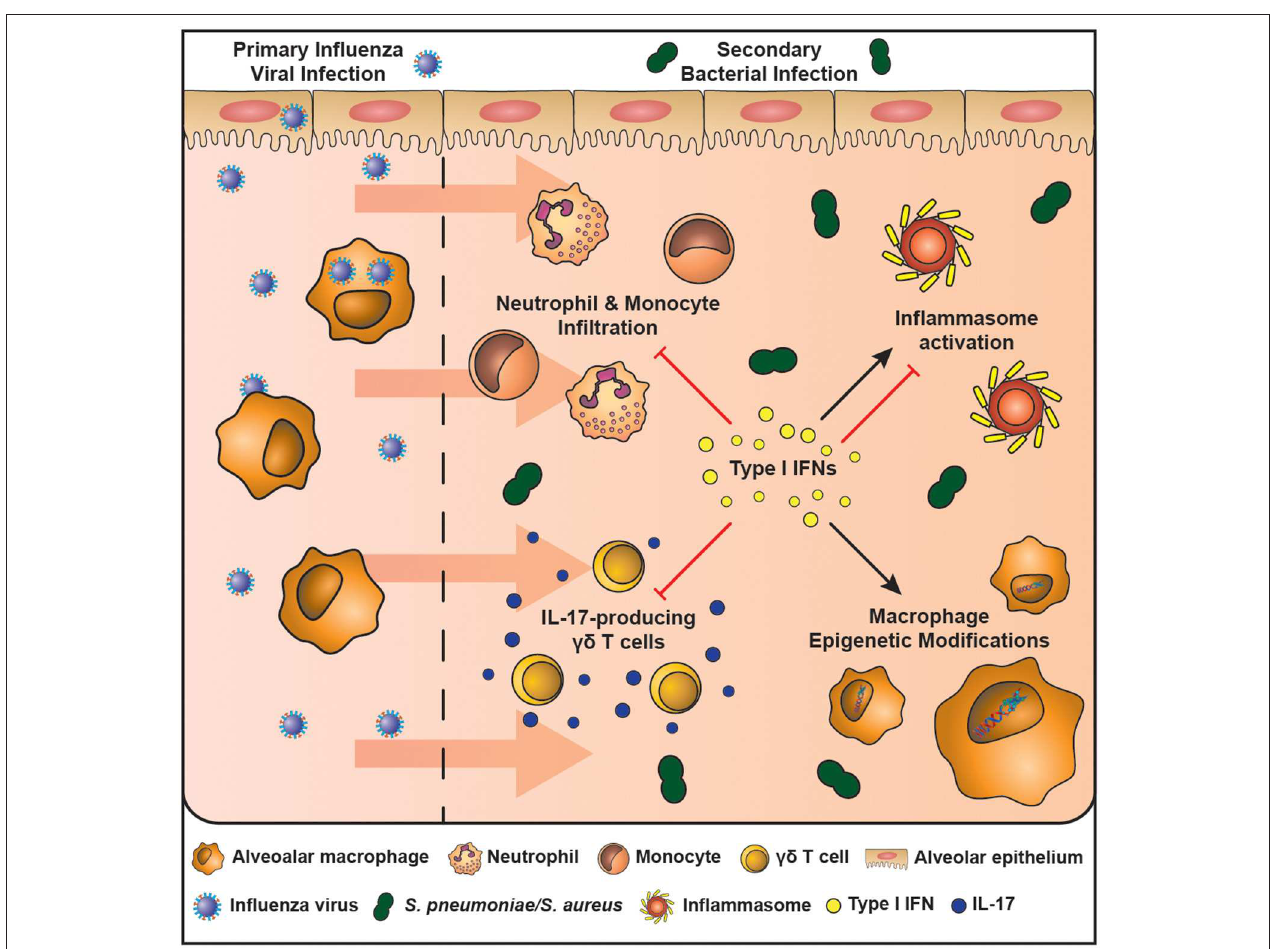
FIGURE 1 | The mechanisms of enhanced host susceptibility to secondary bacterial infection by type I IFNs. Airway epithelial cells and alveolar macrophages are cells of the innate immune system that are at the first line of defense against infection in the airspaces. The influenza virus activates pattern recognition receptors expressed by airway epithelial cells and macrophages and leads to the production of type I IFNs, which are crucial in combating the infection. However, type I IFNs also induce an immunosuppressive state in the resolution phase of infection that enhances host susceptibility to secondary bacterial infection. These mechanisms include: (1) inhibition of IL-17-producing γδ T cells, (2) Induces macrophage epigenetic modifications, (3) Induces or inhibits inflammasome activation in a context-dependent manner, (4) Inhibits neutrophil and monocyte infiltration. These mechanisms result in a lung environment ill equipped to fight an increasing bacterial